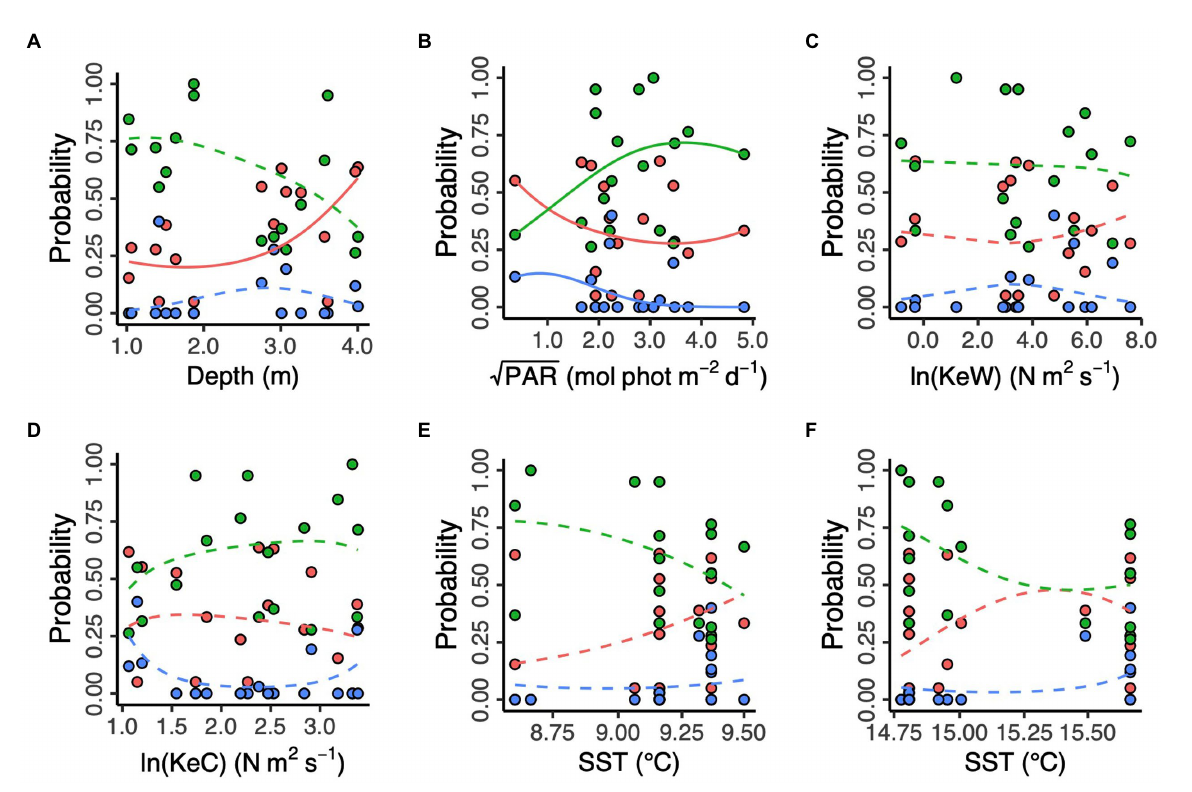
FIGURE 4 Environmental predictors of three putative Zostera marina clusters (“red,” “green,” and “blue”) in 17 locations across the south coast of England. (A) Depth is below chart datum. (B) PAR is photosynthetically active radiation at the seabed. KeW (C) and KeC (D) are kinetic energy, associated with waves and currents, respectively. SST is sea surface temperature in March (E) and August (F) 2016. Solid lines show statistically significant relationships ( p < 0.05), with non-significant relationships shown as dashed